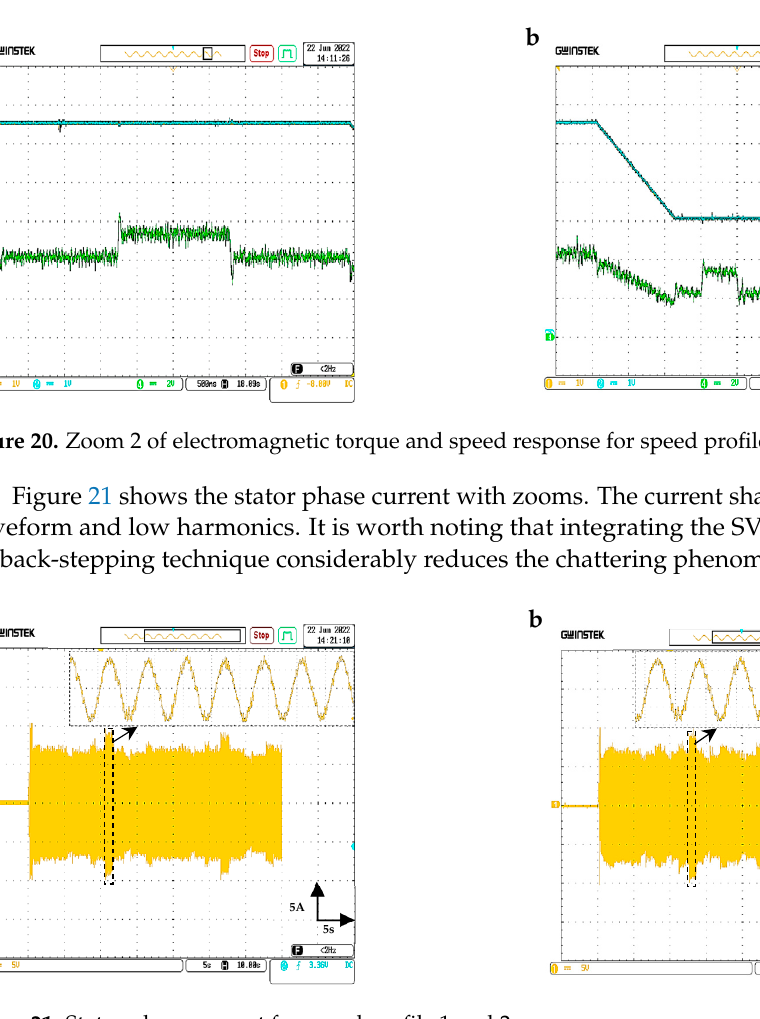
Figure 19. Zoom 1 of electromagnetic torque and speed response for speed profile 1 and 2.